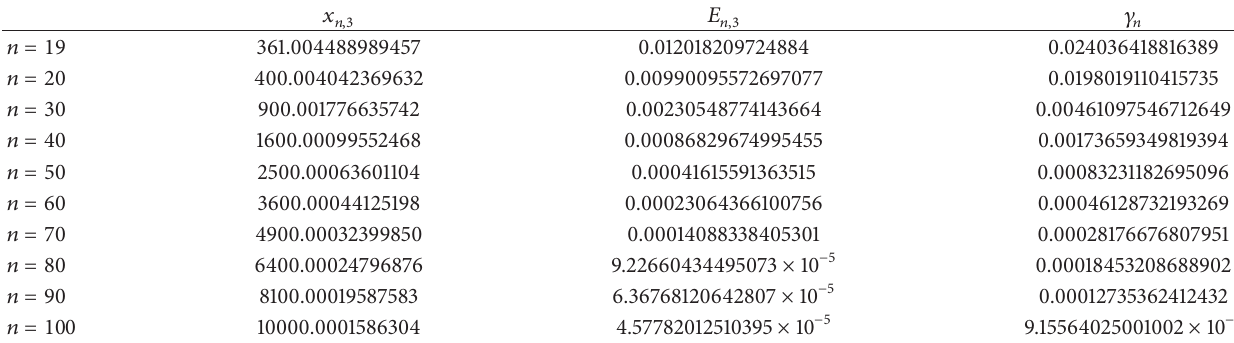
Table 3: Estimations for 𝑇(𝑝 3 )